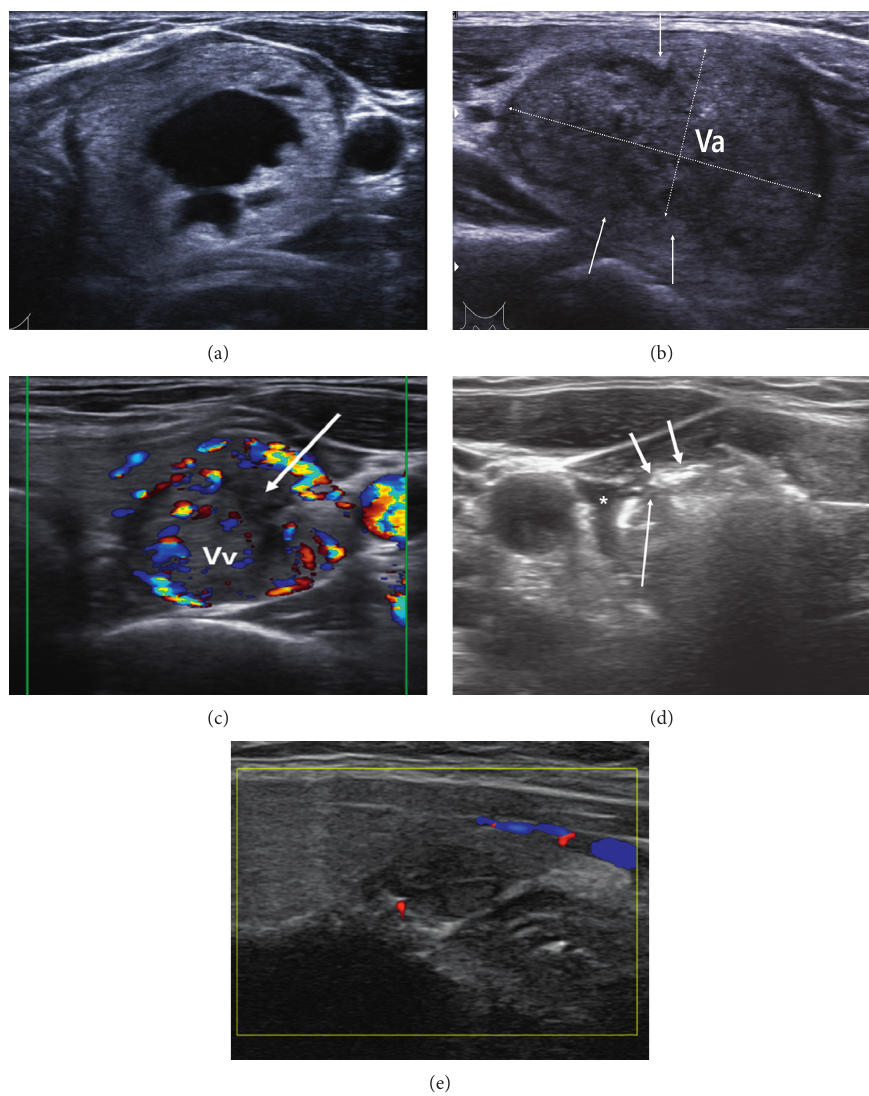
Figure 1: A benign symptomatic thyroid nodule in a 36-year-old female treated with three sessions of radiofrequency ablation (RFA). (a) The nodule was in the patient’s left lower lobe. The longest diameter was 4.7cm, and the volume was 20.6mL. There was no vascularity in and around the nodule. (b) Longitudinal image of the RFA-treated nodule 1 month after the procedure. The total nodule volume ( Vt ) was reduced to 14.5mL and the longest diameter to 3.8cm. The volume reduction ratio was 30%. Ablated tissue located in the central portion of the treated nodule ( Va ) is surrounded by the peripherally located small amount of remaining viable tissue (arrows). The dotted lines indicate the measurements for Va , which best represent the volume of the complex and irregularly shaped ablated area. There was no vascularity. At this time, Va was 11.2mL, the viable volume ( Vv ) was 3.2mL, and the initial ablation ratio was 84%. (c) Color Doppler image of the treated nodule 19 months after the procedure shows the development of vascularity in the nodule. Vt had decreased to 6.8mL, but Va (arrow) had regressed to 1.1mL and Vv had increased to 5.7 mL. Such a Vv increase is an early sign that can predict regrowth, even while Vt is decreasing. As regrowth was expected, the patient received a second RFA in the following month. (d) Thirty-four months after the second RFA, the nodule showed a Vv increase again, and a third RFA was performed. Five percent dextrose injected for hydrodissection can be seen as an anechoic area between the nodule margin and carotid sheath ( ∗ ). The tip of the electrode (long arrow) is located near the veins of the nodule margin to achieve venous ablation. Air bubbles formed by ablation are compactly filling the venous lumen (arrows). (e) Ten months after the third RFA, the nodule had turned into a small scar-like region of tissue without vascularity. The Vt was 0.4mL with no demonstrable Vv